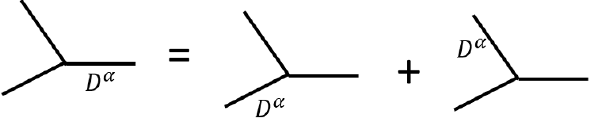
Figure 19. Integration by parts in